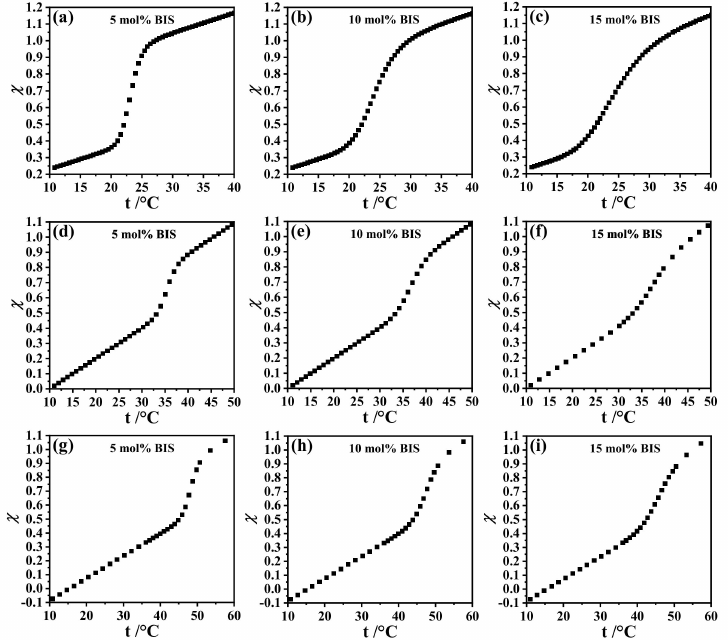
Figure 3. Interaction parameter χ vs. temperature t at different concentrations of BIS in p(NNPAM) ( a – c ), p(NIPAM) ( d – f ), and p(NIPMAM) ( g – i ) particles. The interaction parameter χ was calculated with the Hill-like Equation